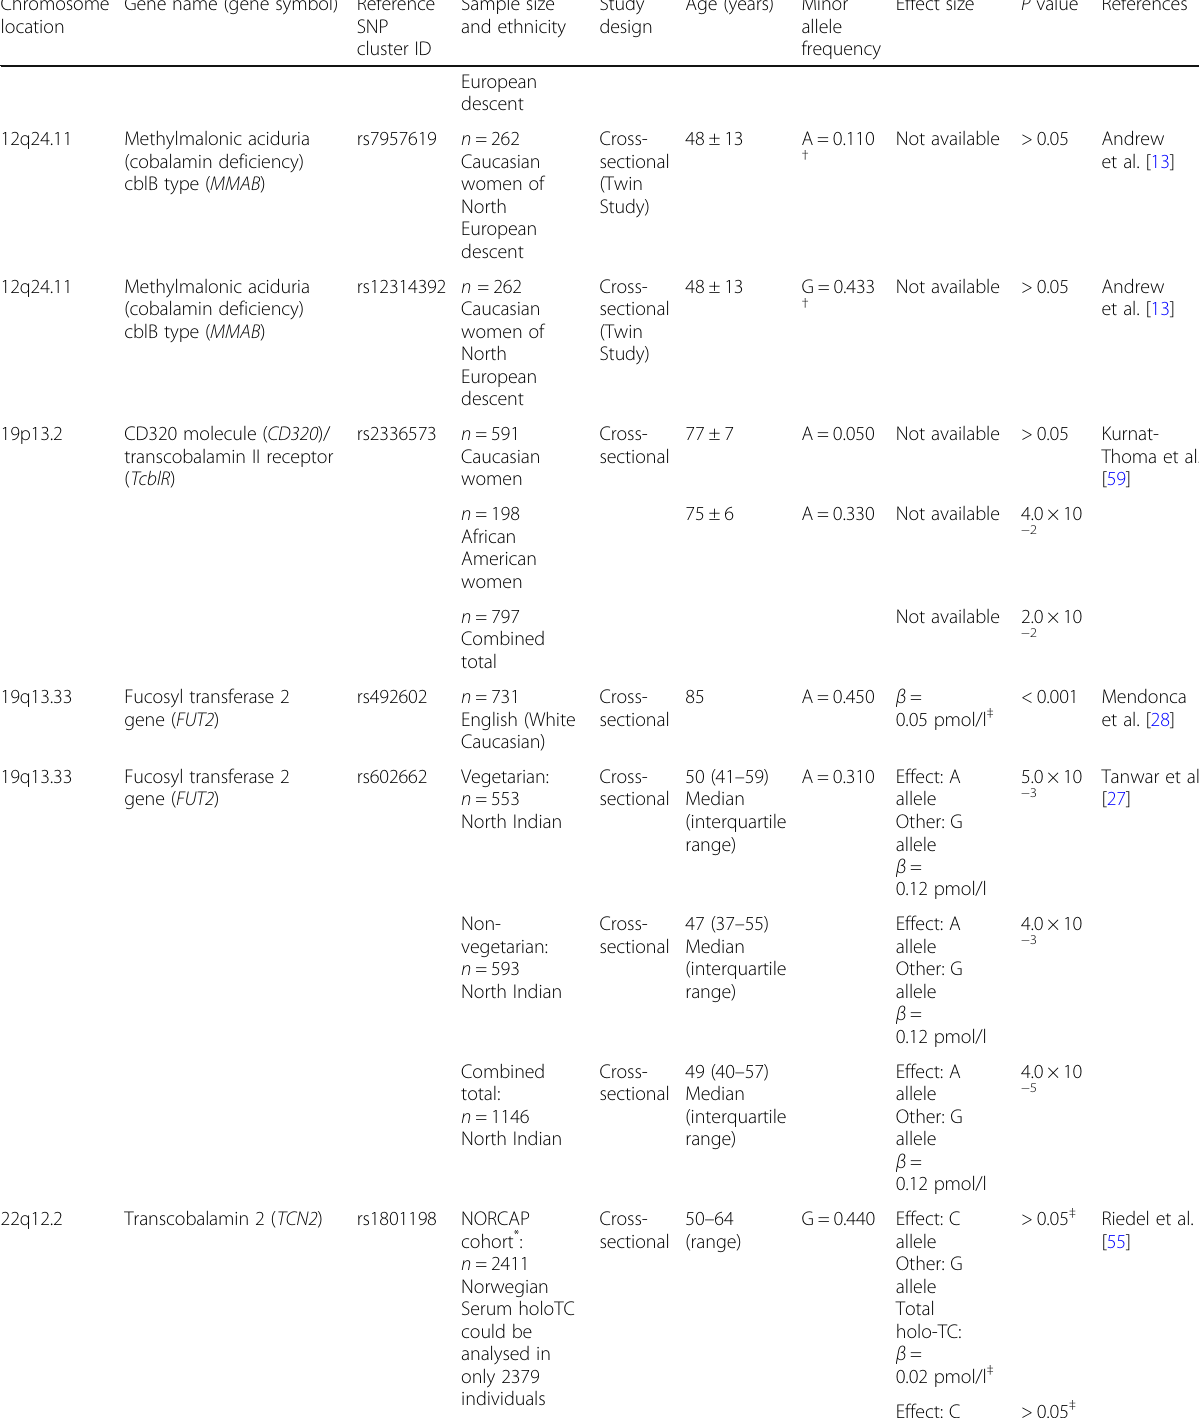
Table 2 Candidate gene association studies examining the association of SNPs with vitamin B12 concentrations. Candidate gene association studies testing the association between SNPs and vitamin B12 concentrations. The chromosome location, gene name, reference SNP cluster ID, sample size and ethnicity, study design, mean age, observed frequency of the minor allele in the population, effect size and P value are shown in the table. The order of SNPs reflects the order of the chromosome location